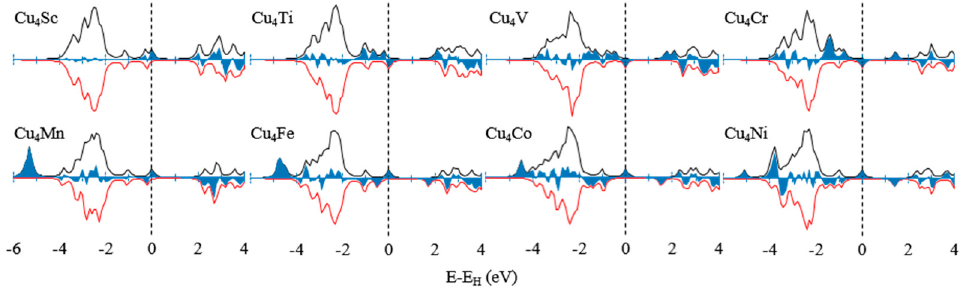
Figure 9. The SDOS of ground state Cu 4 M (M = Sc-Ni) clusters. A broadening factor δ = 0.1 eV is used. Spin up (positive) and spin down (negative) densities are given in each case. The blue part is the density difference (spin up minus spin down). The dashed line indicates the location of the HOMO level.